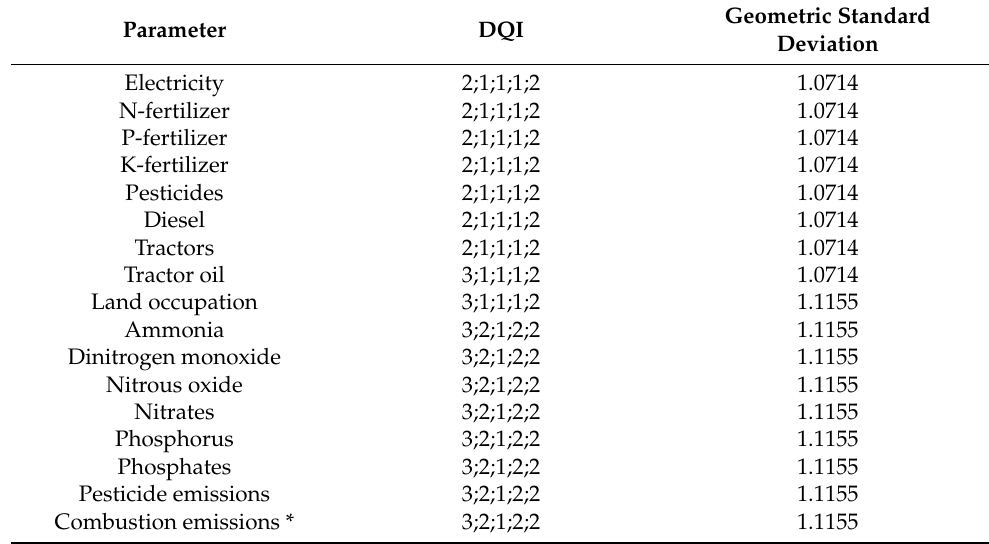
Table A1. Data Quality Indicators (DQI) assigned to each input-output flow for uncertainty analysis.